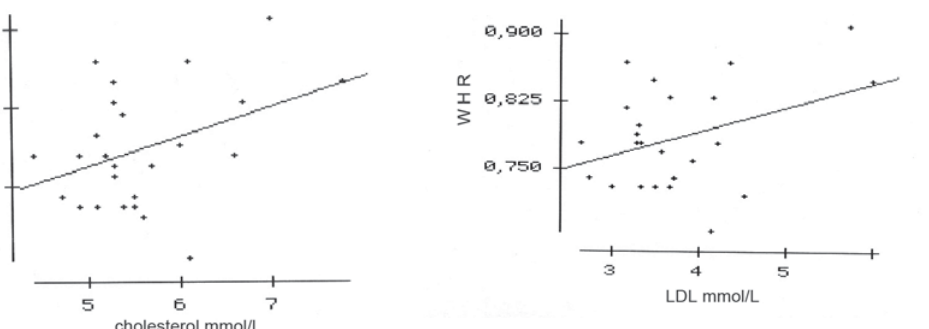
FIGURE 2. Correlation between LDL concentration and WHR in women in menopause